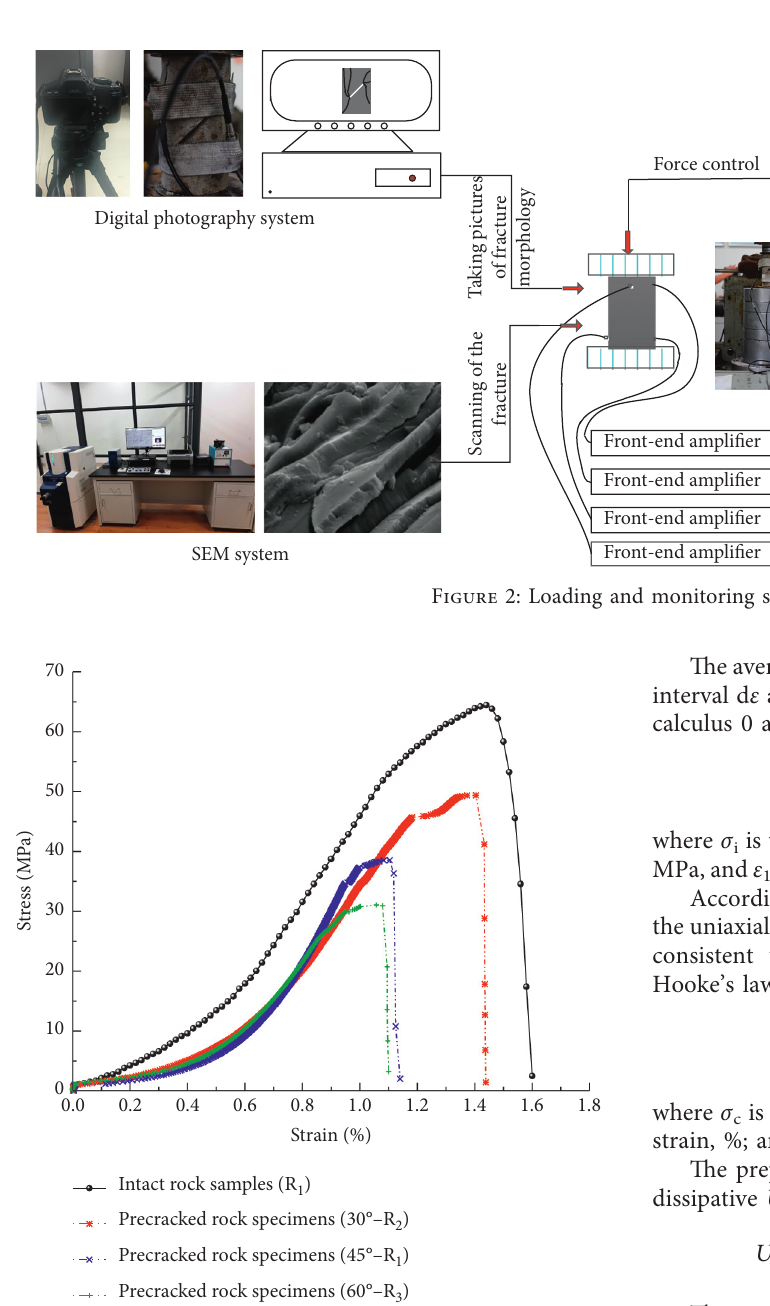
Figure 3: Stress-strain curves of typical intact and precracked rock specimens.